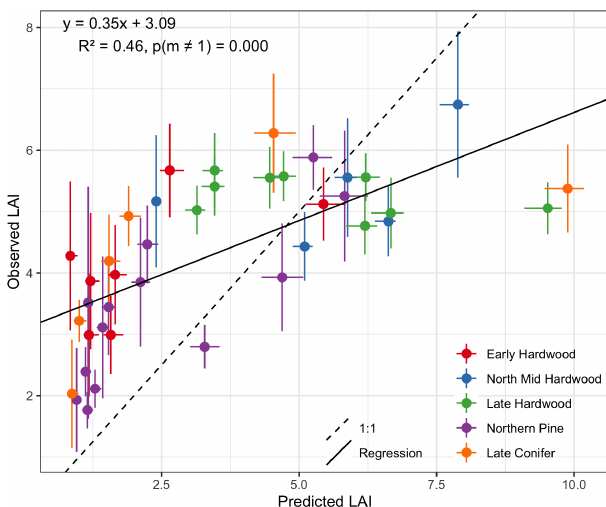
Figure 7. EDR predictions of site-specific true LAI compared to observed values. Horizontal error bars are posterior 95% predic- tive intervals. Vertical error bars are mean ± 1 standard deviation of the observed values. Dashed line shows the 1 : 1 relationship, and solid line is a least-squares predicted vs. observed regression with the equation marked in the upper left corner. Points are colored ac- cording to dominant PFT, calculated as in Fig.